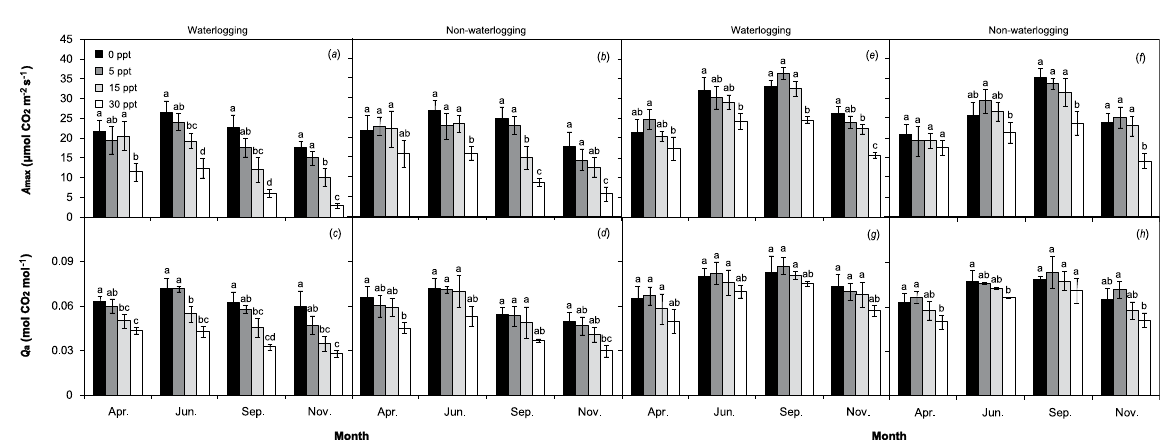
Figure 3. Seasonal variations of the maximum rate of photosynthesis ( A max , mean ± S.D.) and apparent quantum yield ( Q α , mean ± S.D.) of P. australis ( a – d ) and S. alterniflora ( e – h ) under waterlogging and salinity treatments. Different letters indicate significant differences ( P < 0.05) among salinity treatments for each measurement